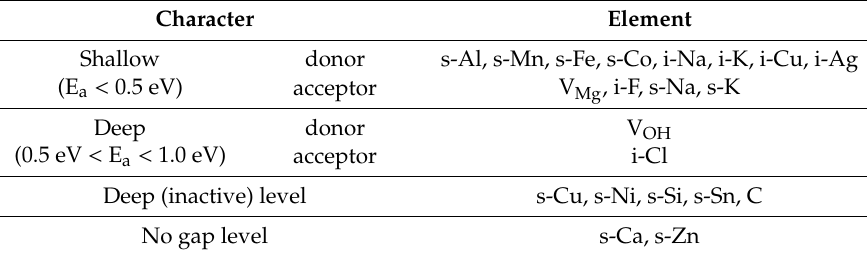
Table 3. Predicted character of impurity atoms in Mg(OH) 2